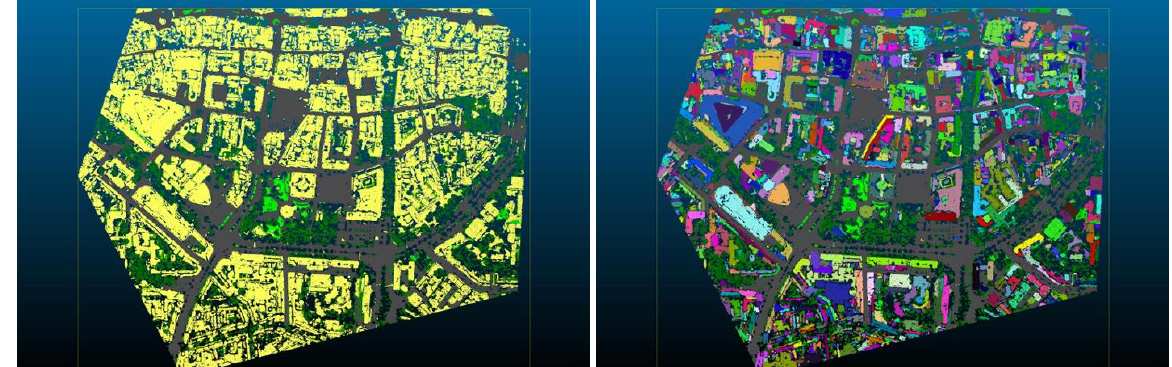
Figure 7. Original 3D point cloud of Dortmund City Center (left) and masked cloud showing everything but the vegetation (right).